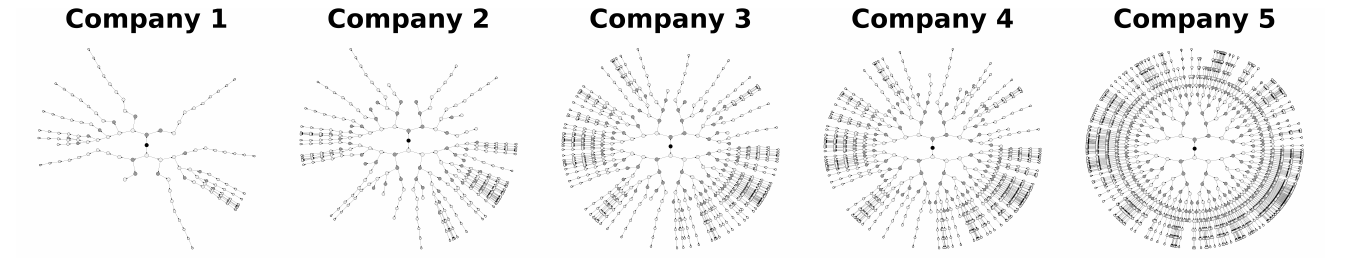
Figure 2. Graphs showing all existing states and its transitions for each of companies that we have.